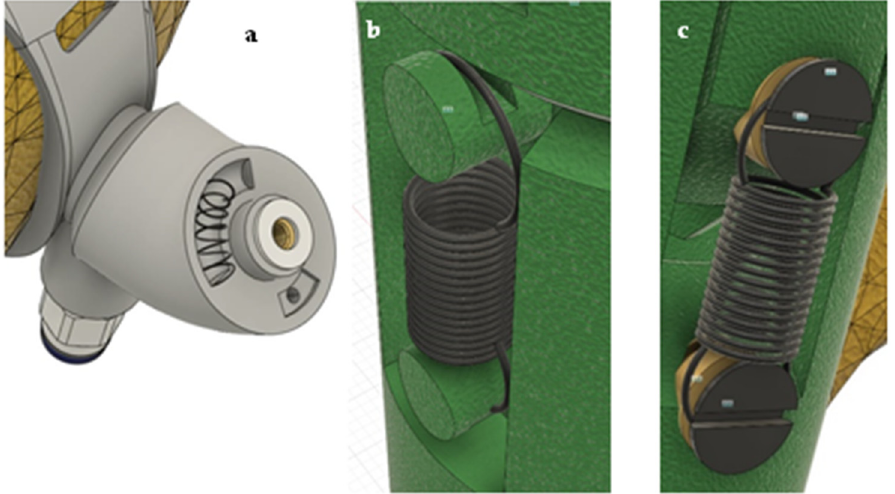
Figure 7. ( a ) Annular grooves for a pressure spring; tension springs attached to ( b ) 3D printed parts of the phalanges; ( c ) additional M2 screws at the ends of the phalanges. After these iteration steps, the final 3D parts (available at